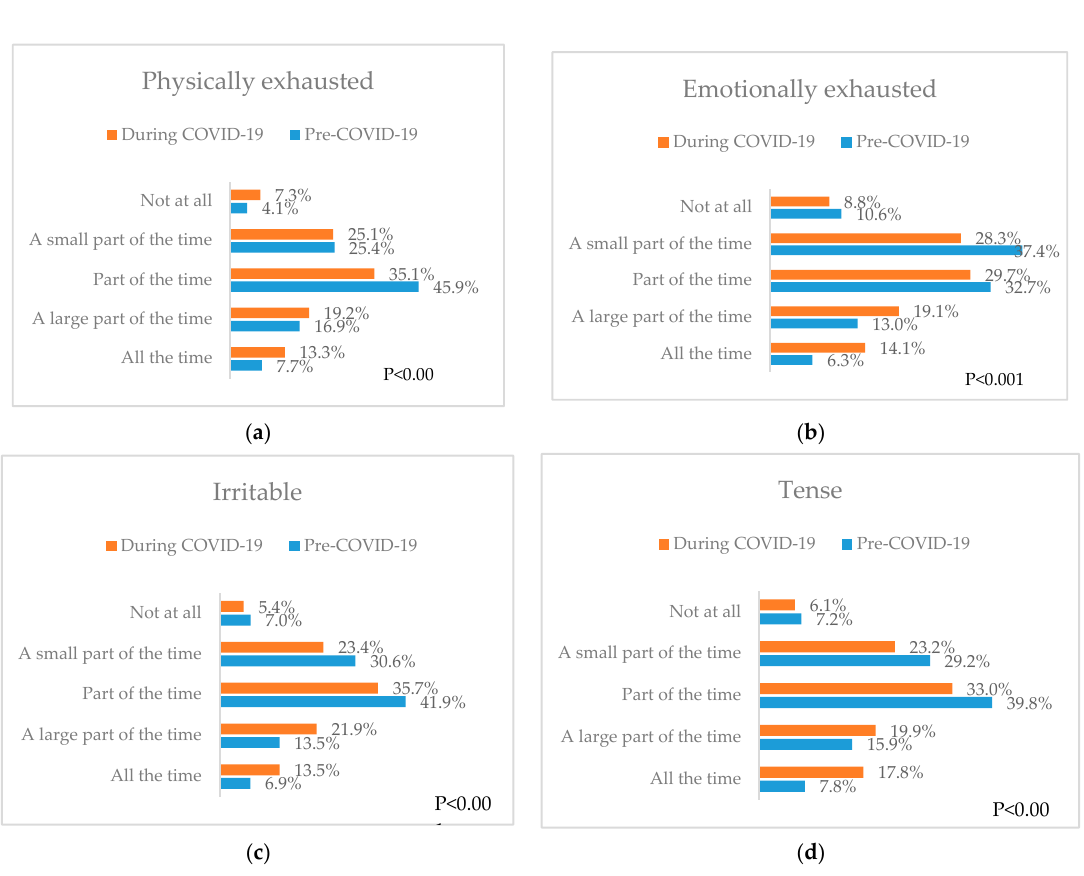
Table 8. Sleep pre- and during COVID-19 pandemic ( n = 1012).